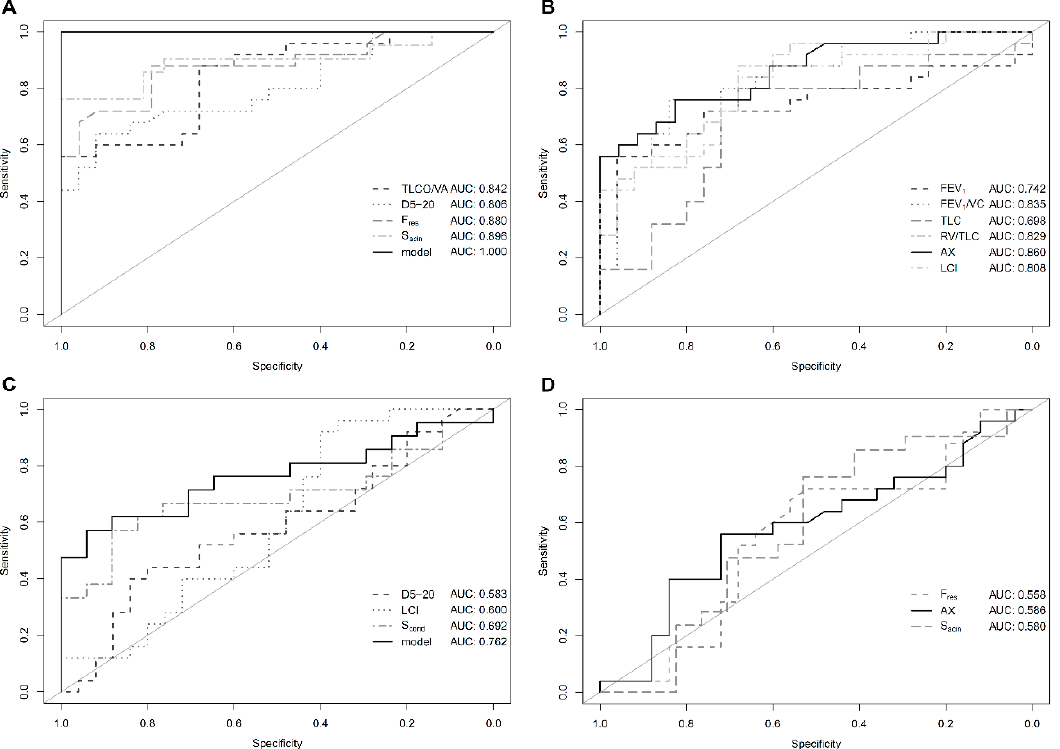
Figure 1. Diagnostic performance: Receiver operating curve (ROC) analysis for conventional and novel lung function parameters in patients with pulmonary hypertension (PH) vs. healthy controls ( A , B ) as well as patients with PH vs. non-healthy controls ( C , D ). Solid black lines indicate best performing parameter of the respective panel. Abbreviations are identical with Table 2. ( A ) Overall good performance of individual parameters selected for inclusion in the generalized linear model. ( B ) Parameters not selected for inclusion in the generalized linear model. ( C ) Generalized linear model with improved diagnostic performance as compared to individual parameters. ( D ) Parameters not selected for inclusion in the generalized linear model.